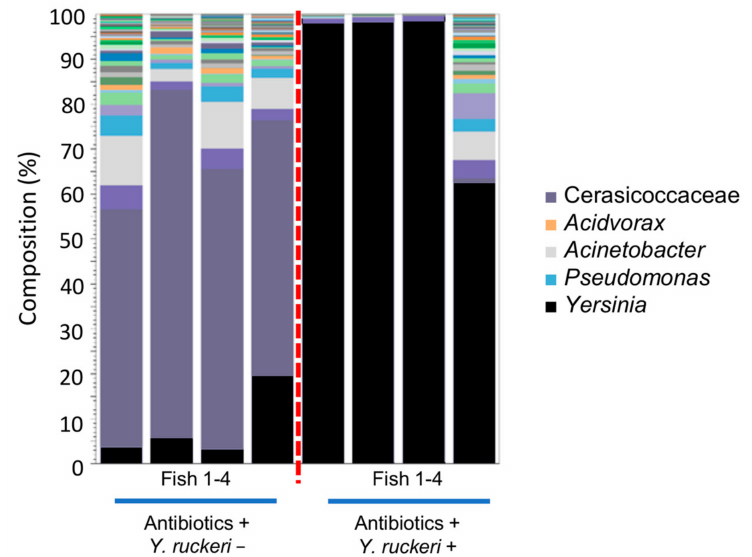
Figure 7. Composition of skin bacterial floras from zebrafish treated with an antibiotic cocktail. The stacked bar chart shows the relative abundance of OTUs (top 50) in skin bacterial floras sampled from antibiotic-treated fish. The samples were grouped by the status of the pathogen challenge ( Y. ruckeri + or −